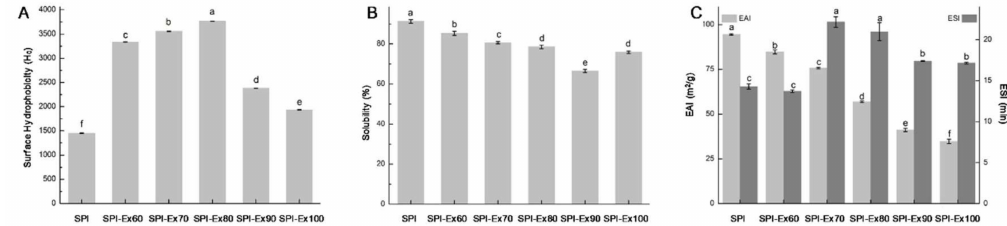
Figure 5. ( A ) surface hydrophobicity, ( B ) solubility, and ( C ) EAI and ESI of SPI extracted from full-fat soybean flakes powder with and without extrusion